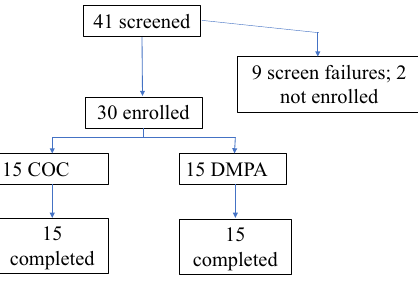
Figure 1. Study Flow Diagram. Consort Diagram showing that 41 potential participants were screened and 30 were enrolled, out of which 15 per group (COC or Depo).